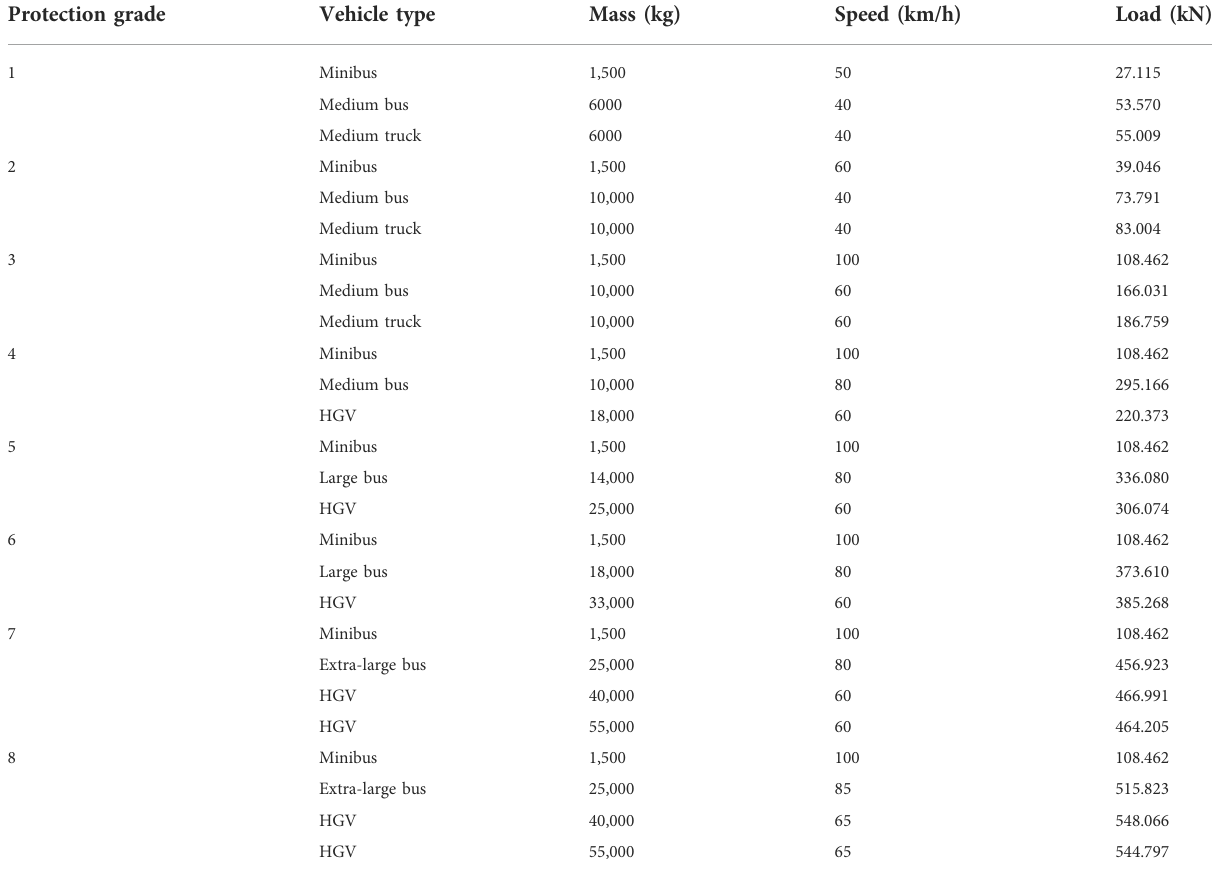
TABLE 1 Calculation parameters of the guardrail